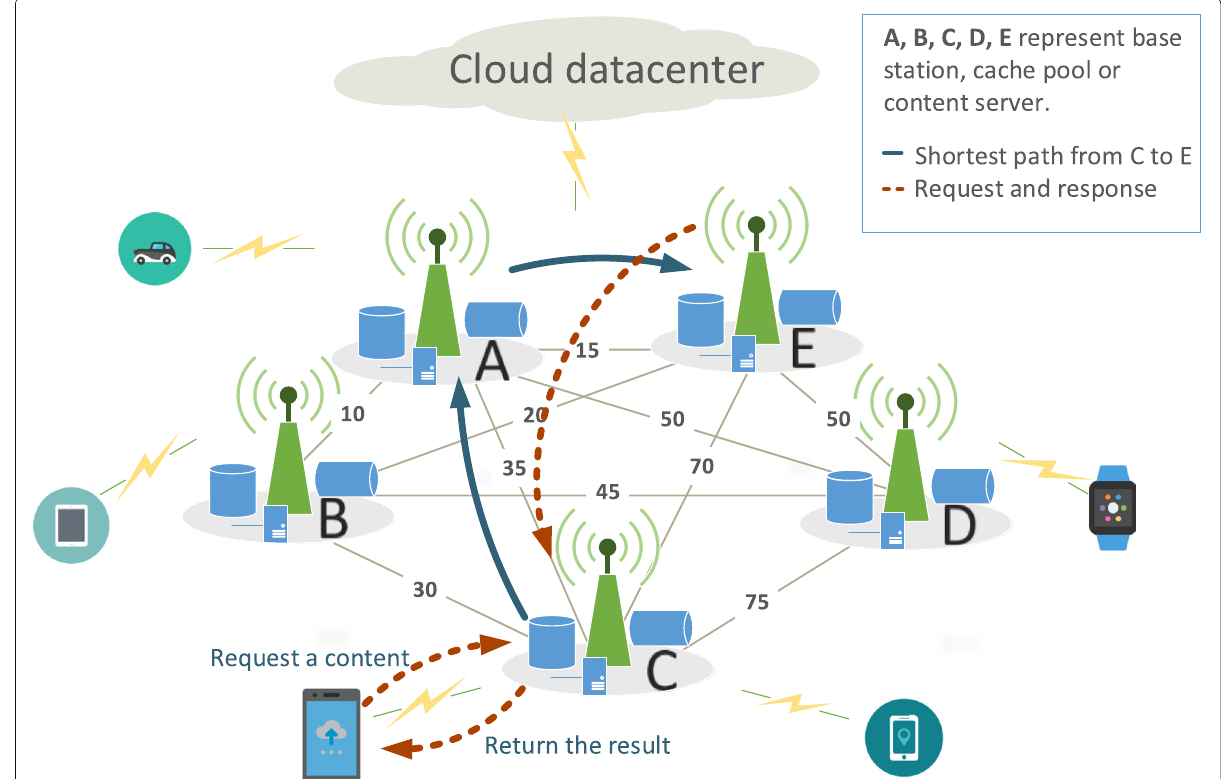
Fig. 2 Example of YouTube video request. A mobile user requests a video from E. Based on the Floyd-Warshall algorithm, the shortest path from C to E is C–A–E. C transmits the request to E through A and E returns the result to C through A. Finally, C provides the video service to the mobile